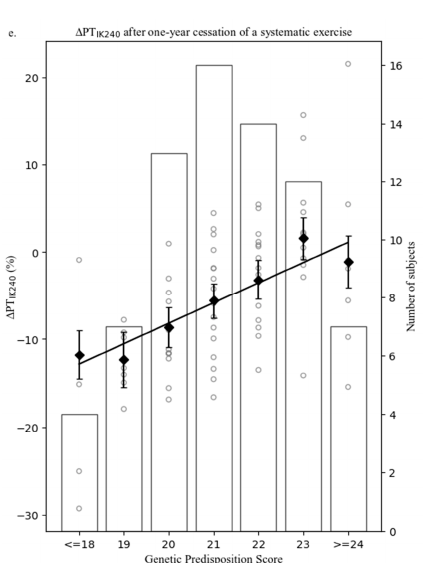
Figure 2. Distribution of GPS and its linear regression model with muscular phenotype changes after one-year cessation of a structured training intervention. ( a ) Linear regression between genetic predisposition score (GPS) and relative change of skeletal muscle mass ( ∆ SMM) in the exercise